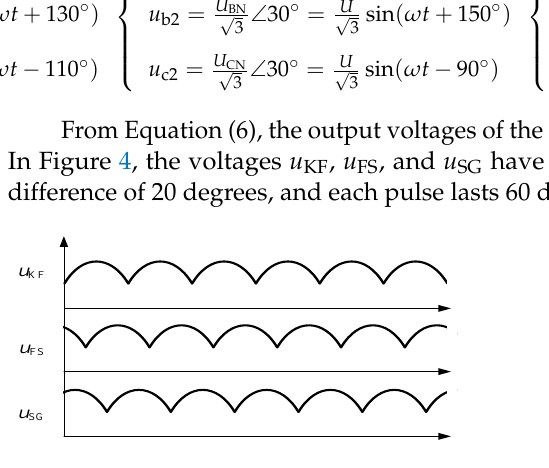
Figure 4. Output voltages of the rectifier bridges.